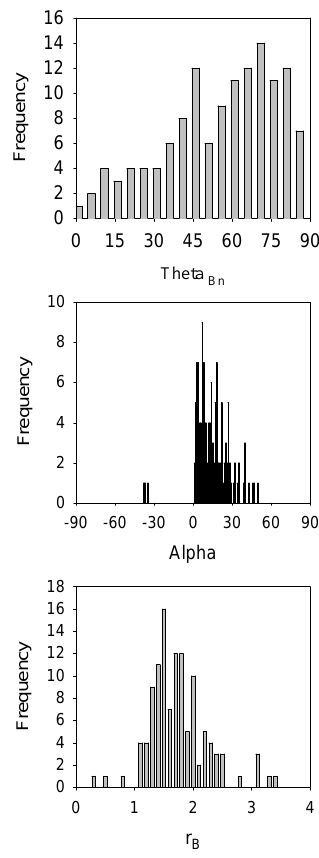
Fig. 2. Example high r B shock occurring on day 146, 1999 show- ing proton density (top panel), proton temperature (2nd panel), pro- ton bulk velocity (3rd panel) and magnetic field magnitude (bottom panel).